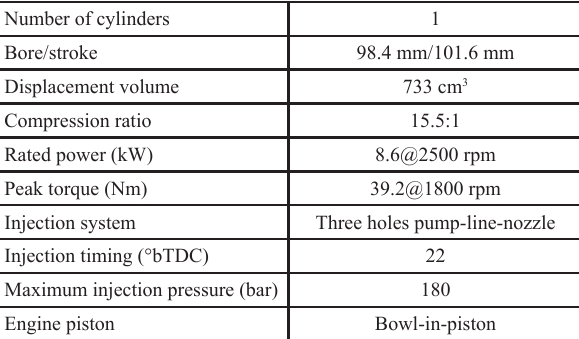
Table 1. Engine specification